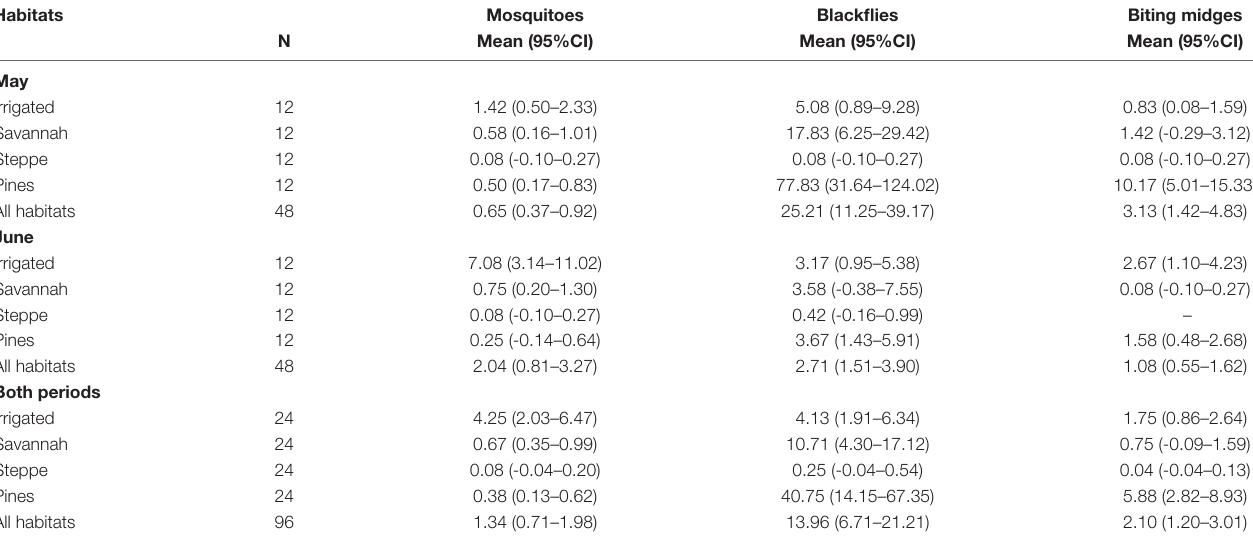
TABLE 2 | Abundance of mosquitoes, blackflies, and biting midges [mean and 95% confidence intervals (CI)] collected in traps in four different habitats (irrigated, oak savannah, steppe and pine forest) and in two sampling periods (May and June). Habitats